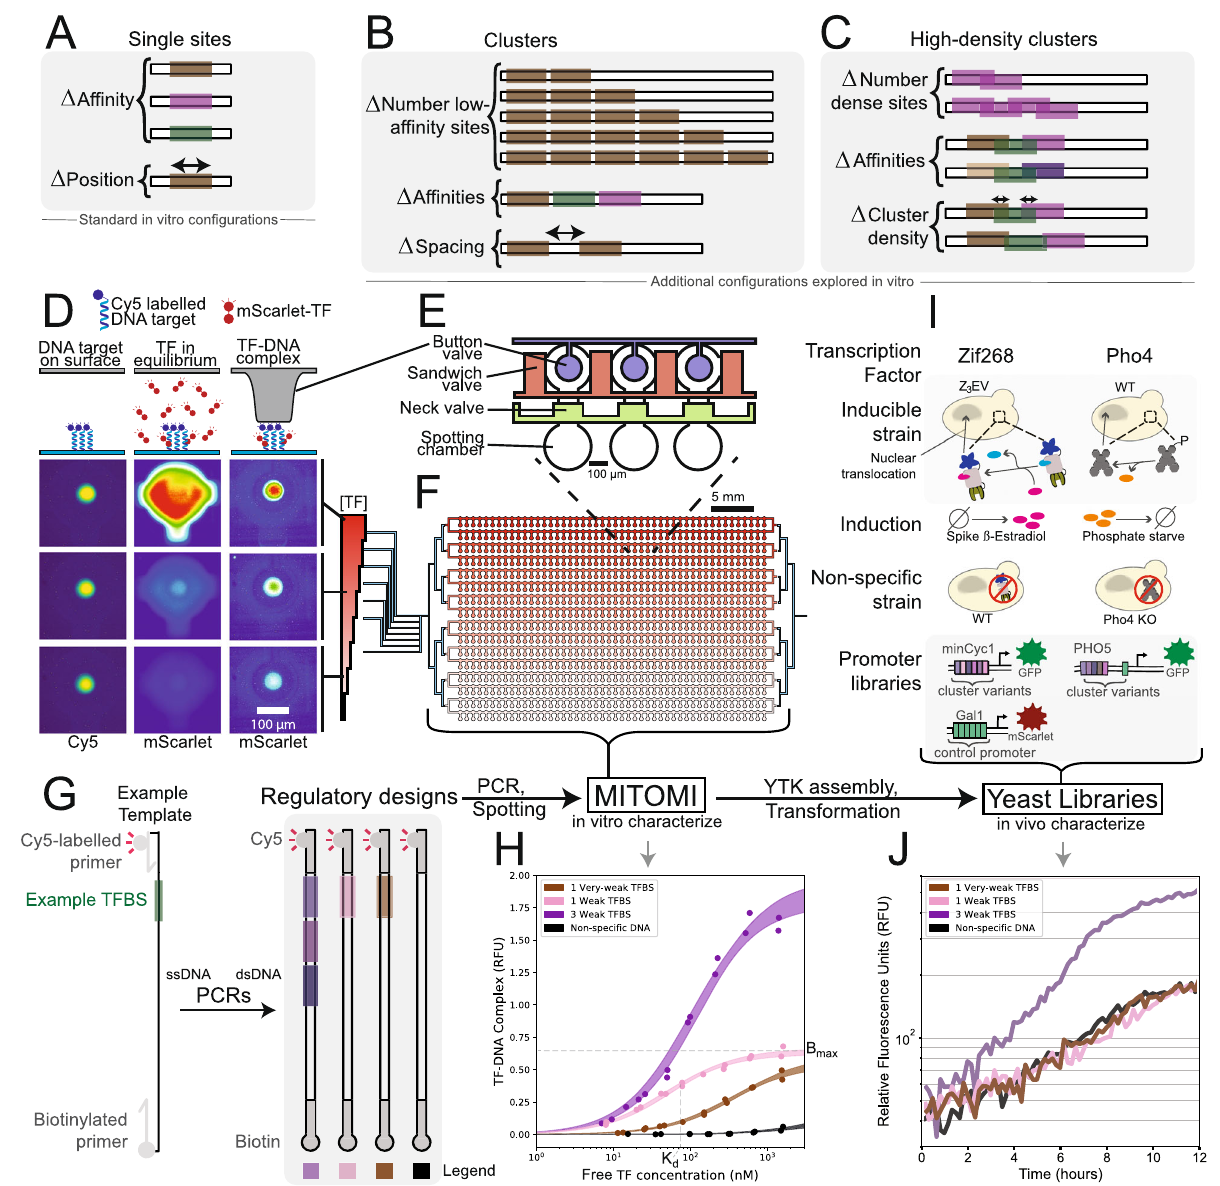
Fig. 1 | Description ofthe in vitro and in vivo measurements. A – C DNA libraries and parameters explored in vitro using iMITOMI, including clusters of multiple binding sites ( B ), and high-density clusters of overlapping binding sites ( C ). D – F Schematic of the high-throughput, in vitro iMITOMI method. The iMITOMI chip consists of two-layers, where microvalves in the control layer ( E ) control the fl ow of fl uid in a fl ow-layer containing 768 programmable reaction chambers ( F ). D Image rows represent different TF concentrations, columns represent stages of the assay. DNA is immobilized on the chip's surface, in each assay chamber, under the button valves (left column). Fluorescently-tagged transcription factor mole- culesare fl owedatdifferentconcentrations(redcolorgradient)intodifferentrows of the chip. The free (middle column) and bound (right column) transcription factorsignalisquanti fi edatequilibrium. G ToobtainthedsDNAtargets,90bp-long